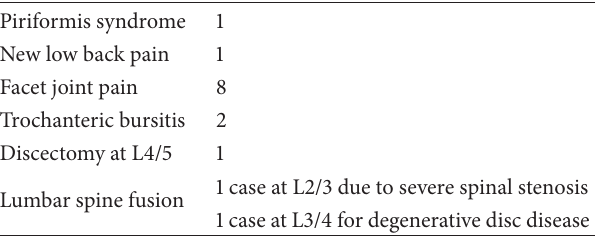
Table 3: Postoperative complications and